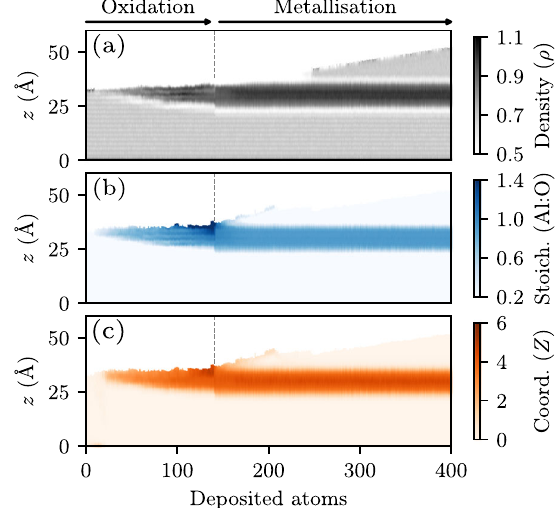
Fig. 9 Structural properties during the junction formation simulation. a Evolution of the density as the growth of a complete Al – AlO x – Al junction is simulated. The change from oxygen to aluminium deposition is indicated by the vertical dashed lines. b Evolution of the stoichiometry. c Evolution of the coordination. This calculation was performed with the S – M